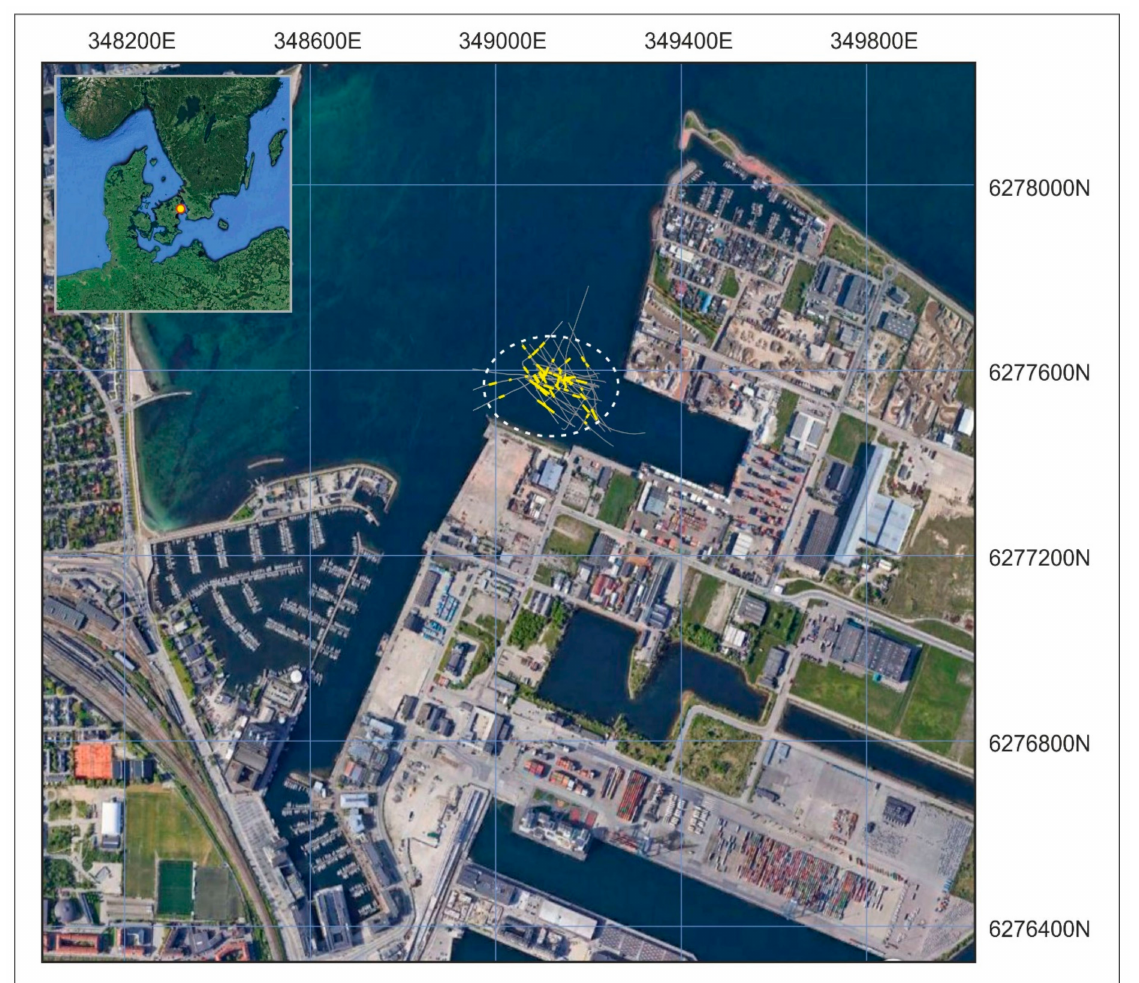
Figure 17. Map of the acoustic anomaly in Svanemøllen Harbour, Copenhagen, Denmark. The sailing lines are grey, the response features (haystacks and narrow noise columns) are yellow. Zone 33 UTM coordinates. Graphics: